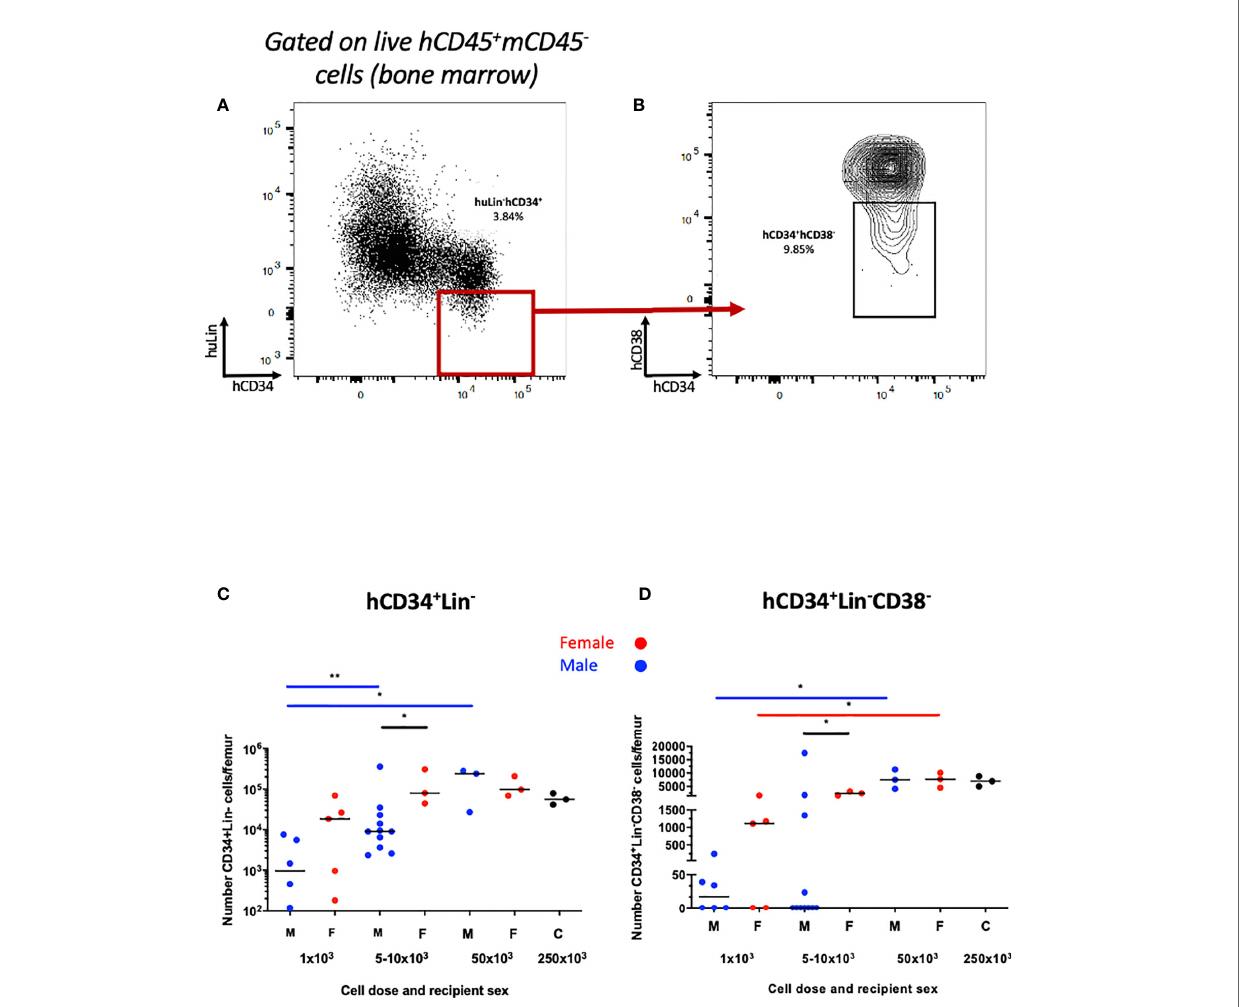
FIGURE 2 | Human HSPC engraftment in the bone marrow of HSPC-NBSGW mice. Representative dot plots of (A) hCD34 + Lin - and (B) hCD34 + Lin - hCD38 low\- HSPCs in the bone marrow. Number of (C) hCD34 + Lin - and (D) hCD34 + Lin - hCD38 low\- cells per femur in male and female recipients at the point of harvest (20-22 weeks). M- male (blue symbols), F- female (red symbols), 250x10 3 – control group (mixed sex). Statistical signi fi cance was assessed using a Mann Whitney test (*p<0.05, **p<0.01). Median values